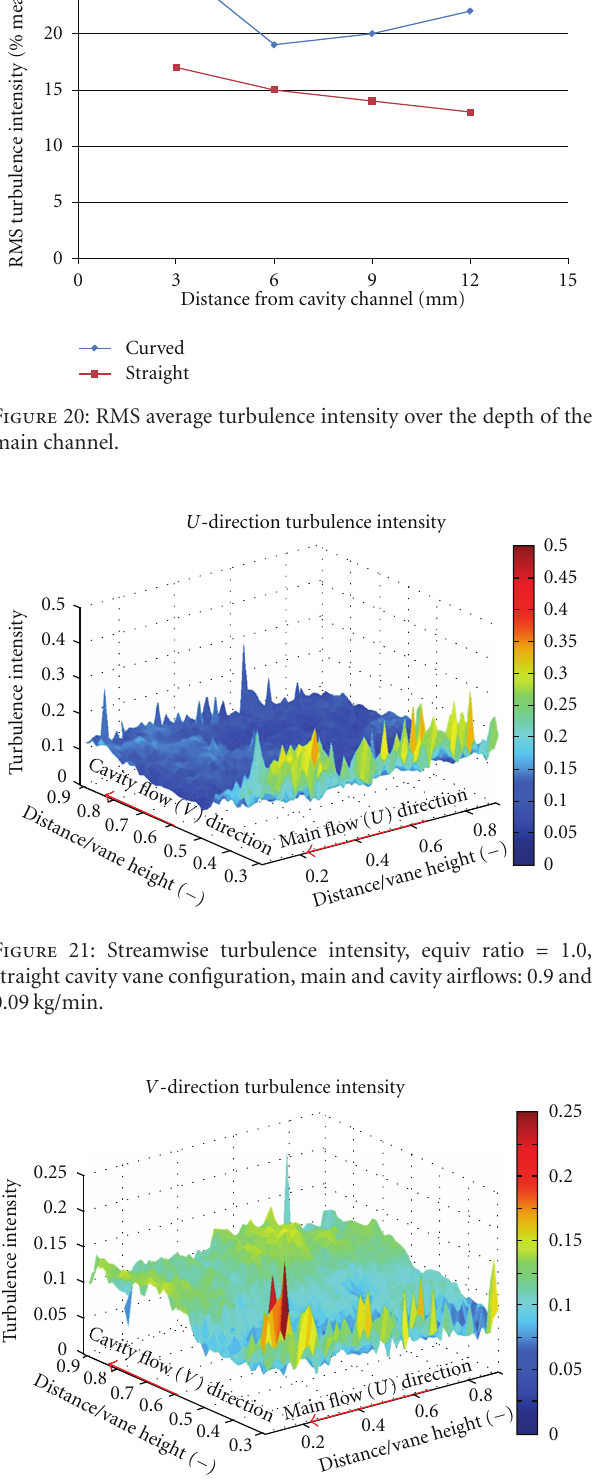
Figure 22: Spanwise turbulence intensity, equiv ratio = 1.0, straight cavity vane configuration, main and cavity airflows: 0.9 and 0.09 kg/min.